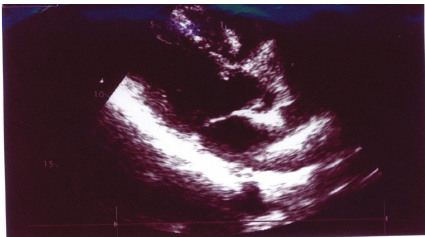
Figure 1: Transthoracic echocardiography revealed a round pedun- culated semimobile dense mass (1.6cm ∗ 1.8cm) in right ventricular outflow tract (RVOT) with attachment to the base of the septum.